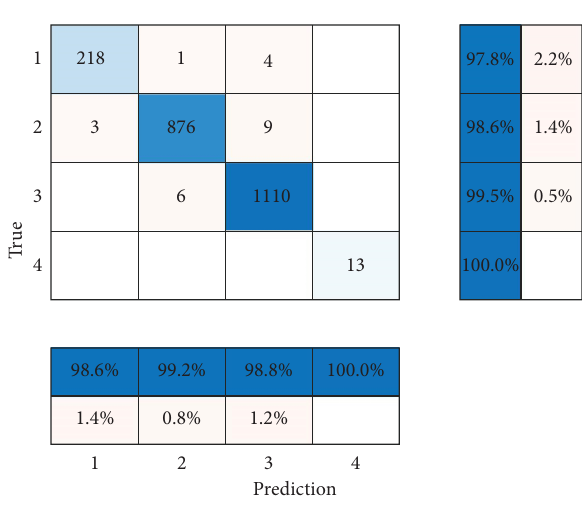
Figure 5: Training confusion matrix.